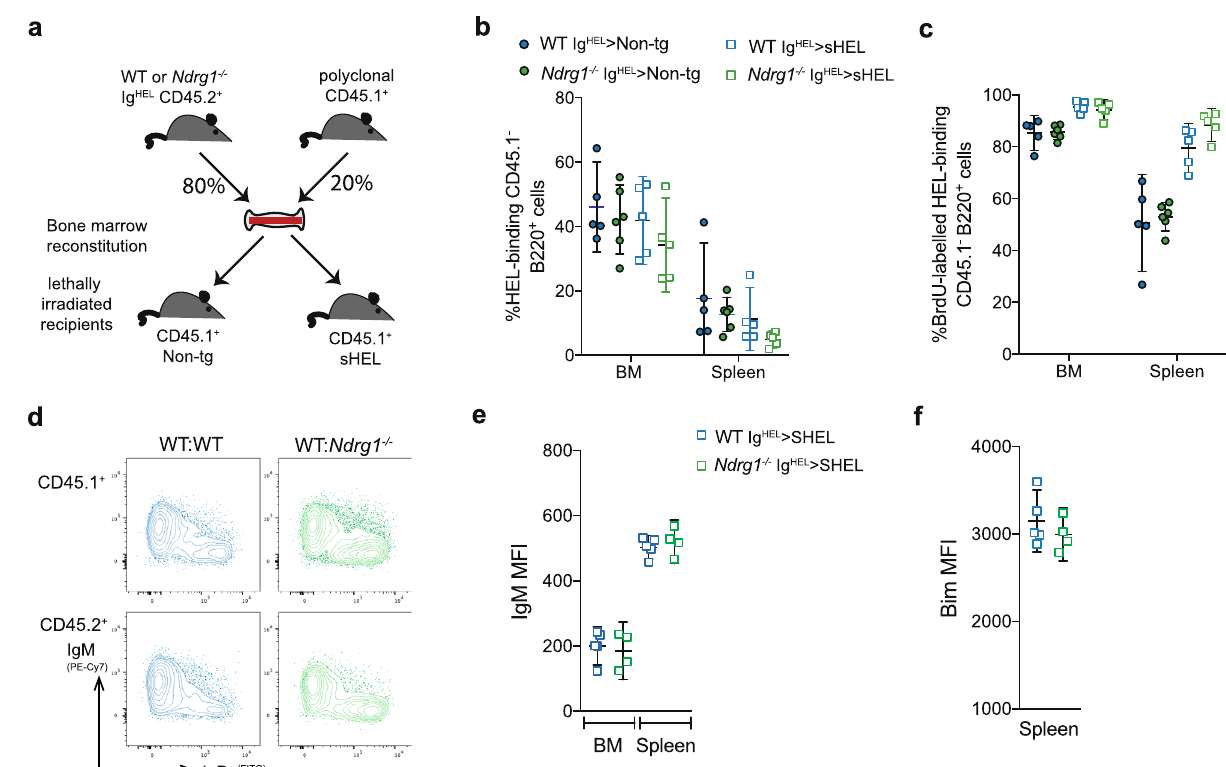
Fig. 5 Anergic B cells lacking NDRG1 survive and compete normally in a polyclonal repertoire. a Experimental schematic; lethally irradiated WT or sHEL transgenic CD45.1 + recipients were reconstituted with 80:20 mixtures of WT or Ndrg1 − / − Ig HEL CD45.2 + BM and WT non-tg CD45.1 + BM. b Percentage of total HEL-binding B220 + CD45.1 − cells in the BM and spleen of mice in ( a ). c Percentage of HEL-binding B220 + CD45.1 − cells labeled with BrdU after one week. In ( b , c ), dots are individual mice from one experiment with 5 – 6 mice per group, lines show means and 95% CI error bars. d. Representative fl ow cytometry plots of B220 + CD43 − B cells from BM of sHEL mice reconstituted with 50:50 mixtures of WT Ig HEL CD45.1 + BM with either WT Ig HEL or Ndrg1 − / − Ig HEL CD45.2 + BM. e Surface IgM expression on B cell populations gated as in ( d ). f Intracellular Bim quanti fi cation in B220 + CD19 + IgD a + splenocytes from ( d ). Each point represents individual mice and lines represent means with 95% CI error bars from one experiment (4 – 5 per Table 1 Anergic B cells lacking NDGR1 survive and compete normally in a polyclonal repertoire. Tissue BM (×10 6 ) Spleen (×10 6 ) Recipient Non-tg sHEL